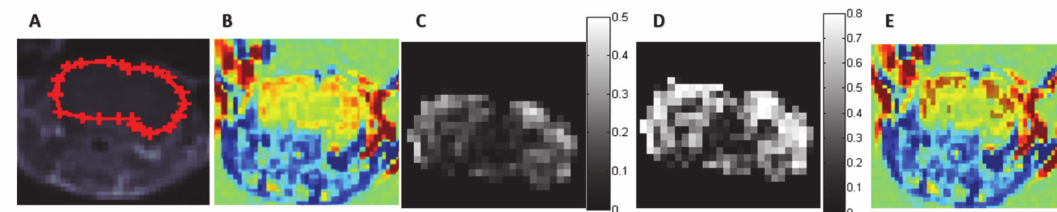
Figure 1. Examples of calculated maps: ( A ) A T1-MRI slice with the plotted brain region of interest (ROI) overlaid. ( B ) Treatment response assessment maps (TRAMs) calculated by subtracting the 1st series post-contrast from the series obtained 30 min post-contrast injection showing red (contrast accumulation) regions (demonstrating higher blood–brain barrier disruption (BBBd) in the cortex). ( C ) Maximal intensity increase map in the same brain slice. ( D ) r 2 map depicting the fit r 2 of each pixel in the same brain slice. ( E ) Pixels included in the BBBd ROI (intensity increase > 5% and r 2 > 0.6), marked in brown and overlaid on the